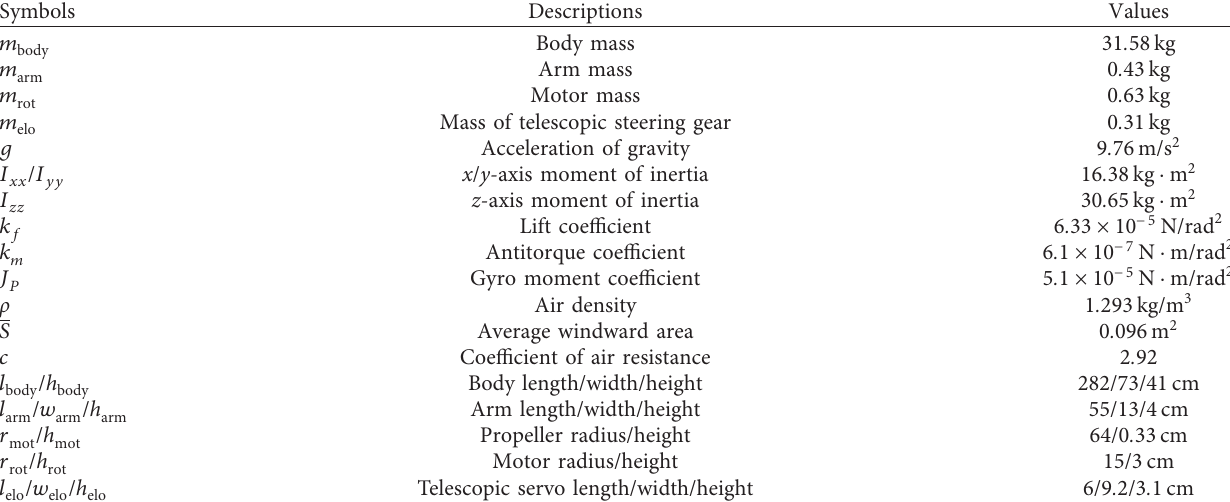
Table 2: Simulation parameters of the system.